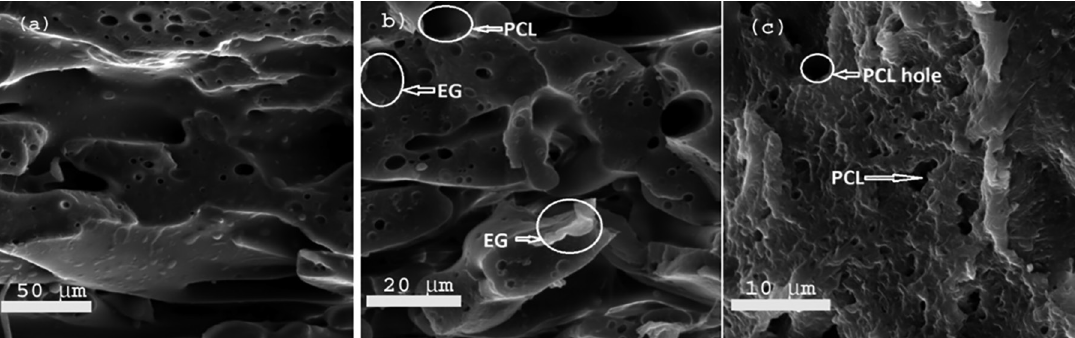
material were tabulated in Table 1. The average size of the d - or basal spacing ( d ), which is the sum of the layer and 200 interlayer distances between the EG platelets and composites, was determined from the 2θ position of the ( d ) diffraction 200 peak of each material using Bragg’s law (equation 1) and tabulated in Table